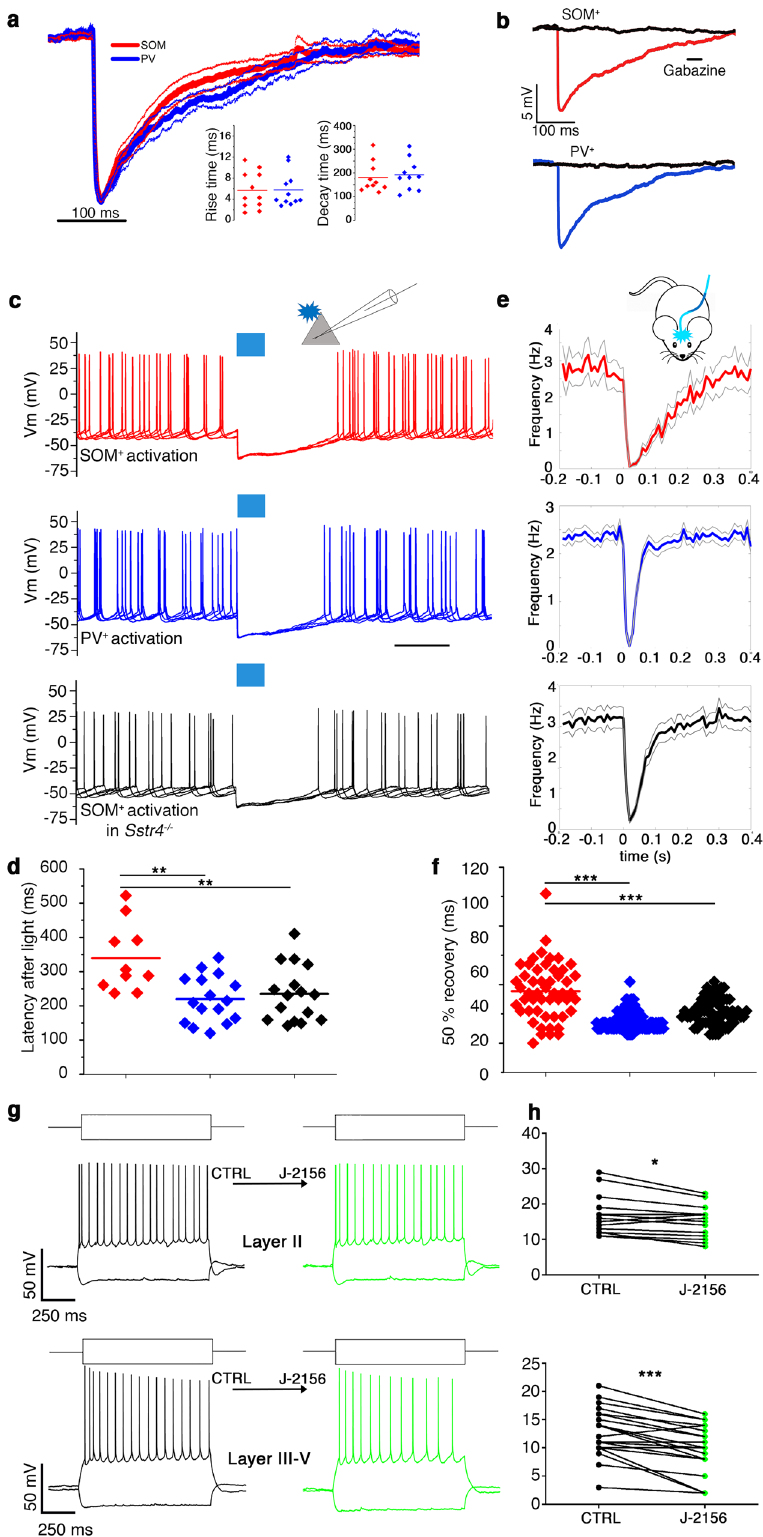
SOM + interneurons; the layer III – layer V pyramidal neurons showed a prominent decrease in fi ring frequency when the SST4 receptor agonist J-2156 was applied. Considering that the SST4 receptor mainly acts positively on M-currents 35 , our results are in agreement with the proposal that, under the M-current block, the pyramidal cells excitability in MEC layer III – V increases 37 .